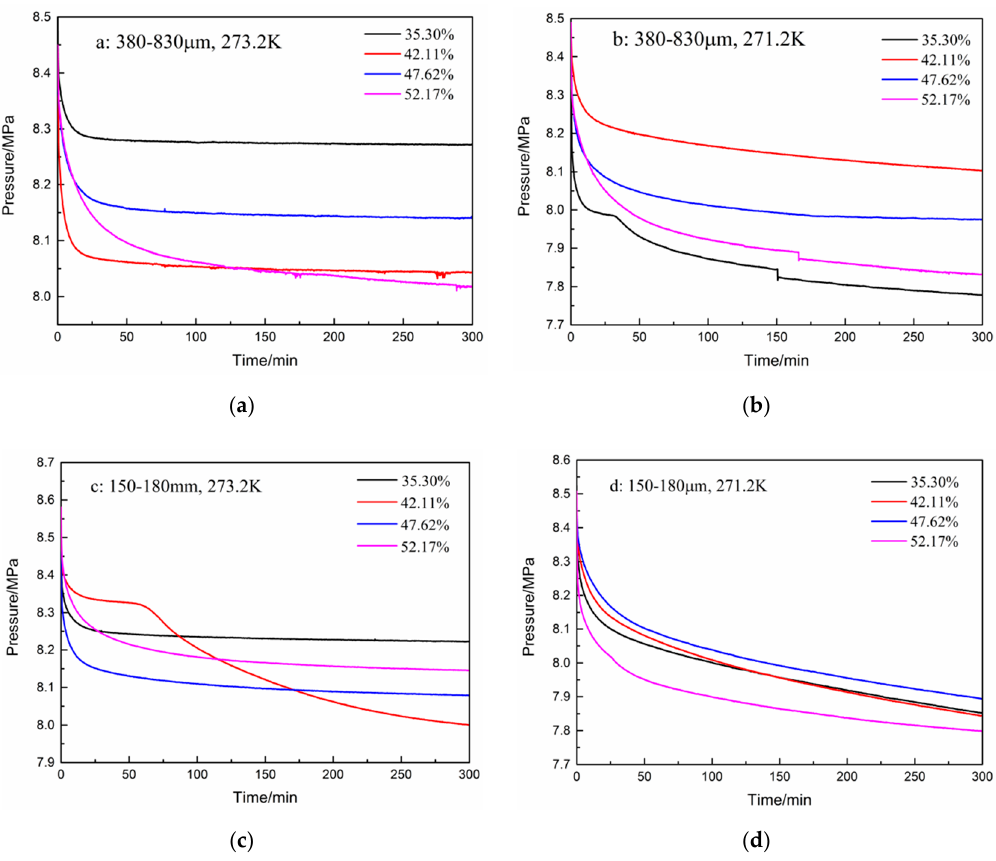
Figure 2. Pressure drops for zeolites having different water contents at various temperatures. ( a ): 380–830 µ m, 273.2 K; ( b ): 380–830 µ m, 271.2 K; ( c ): 150–180 µ m, 273.2 K; and ( d ): 150–180 µ m, 271.2 K.